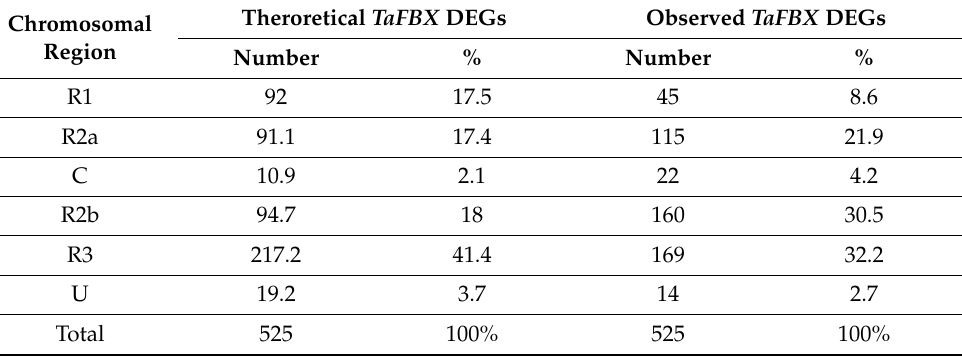
Table 3. Comparison of the observed and theoretical distributions of the TaFBX genes responding to abiotic stress according to their anchorage in the chromosomal regions (X-squared test = 46.212, df = 5, p -value = 8.222 × 10 − 9